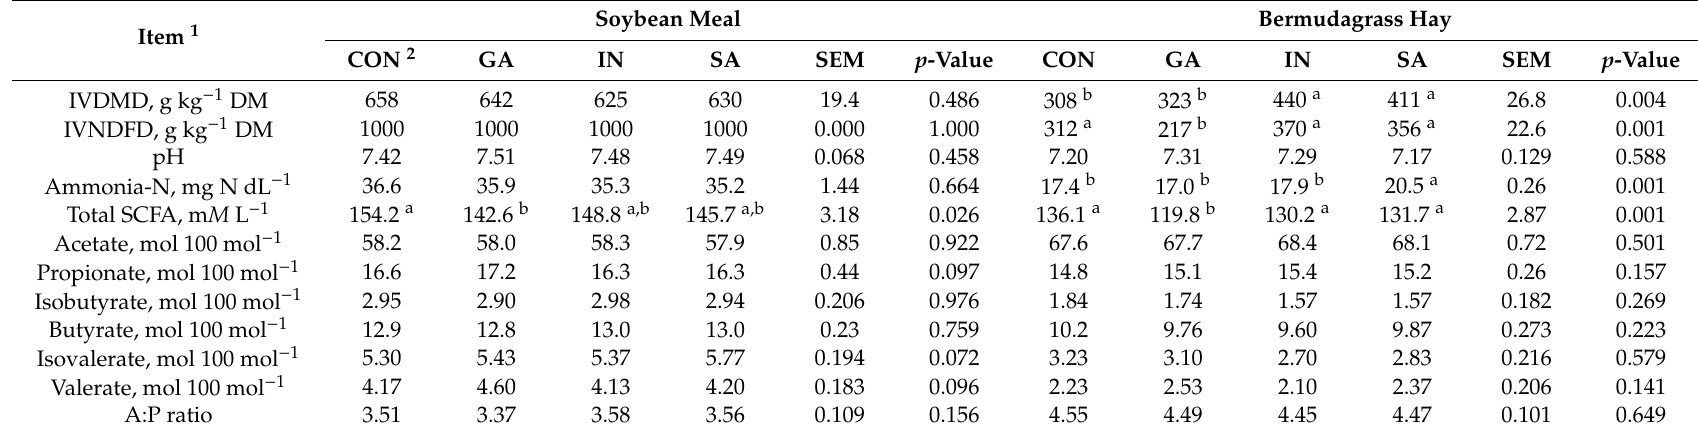
Table 3. E ff ects of Essential Oils from Di ff erent Wormwood Species on In Vitro Digestibility and Fermentation Indices of Soybean Meal and Bermudagrass Hay after 72 h of Incubation in Bu ff ered Rumen